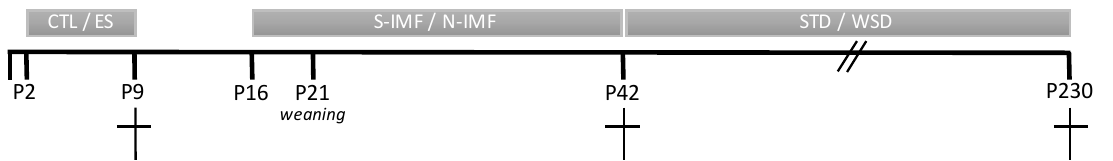
Figure 1. Experimental design. Animals were exposed to control (CTL) or early-life stress (ES) conditions from postnatal day (P)2-P9. Postnatal diet (standard infant milk formula (S-IMF) or Nuturis ® IMF (N-IMF)) was provided from P16 to P42, and standard diet (STD) or western-style diet (WSD) from P42 to P230. Animals were sacrificed at either P9, P42, or P230.